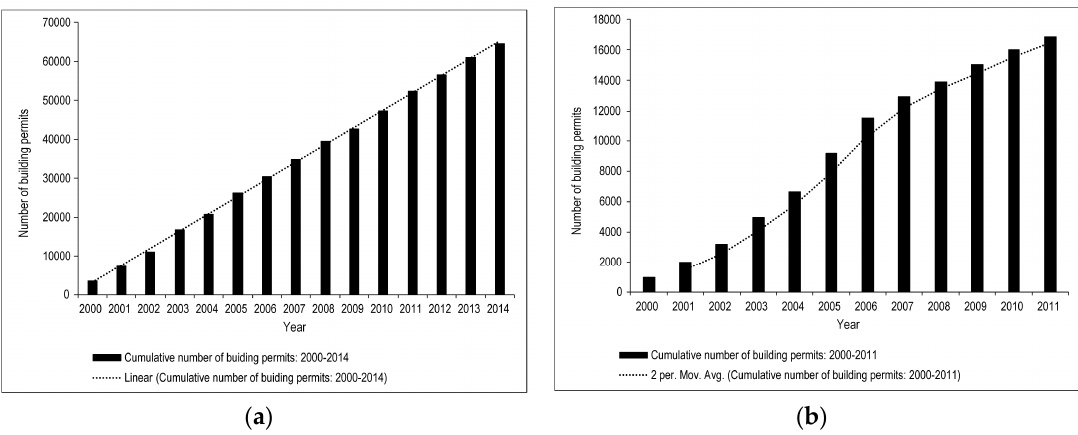
Figure 8. ( a ) Cumulative total number of building permits in for the City of El Paso, 2000–2014; ( b ) Cumulative total number of building permits in the City of Las Cruces, 2000–2011. Table 5. Summary of land cover results calculated from National Land Cover Database (NLCD) in ArcGIS Online compared to results from this study.